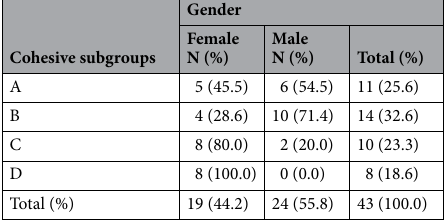
Table 3. The relationship of actors belonging to the different cohesive subgroups and their gender.